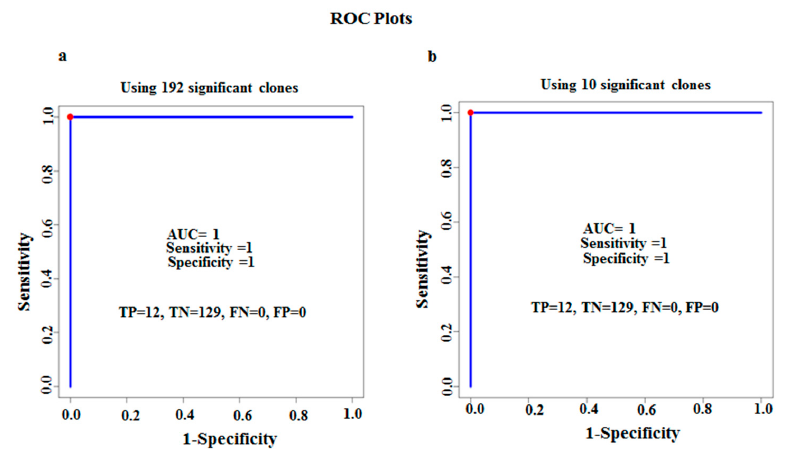
Figure 3. Classifiers to predict TB from healthy controls and sarcoidosis patients. ( a ) Performance of 192 clones on test set. ( b ) Performance of the top 10 classifier clones on test set. The ROC curves demonstrate excellent classification performance with AUC of 1 with sensitivity of 1 and specificity of 1.